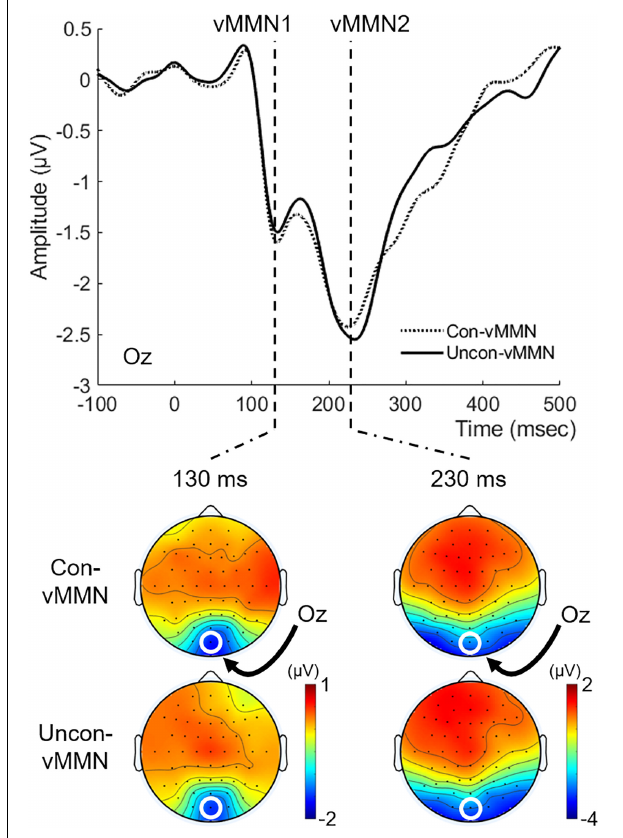
FIGURE 4 | Grand-averaged vMMNs to the target image. vMMN at Oz and topographical maps at latencies of 130 and 230 ms were shown for each condition. Two successive vMMNs (vMMN1 and vMMN2, see “Electroencephalography Data” section) emerged. vMMNs evoked in both the Uncon-DEV condition and the Con-DEV condition prominently appeared at